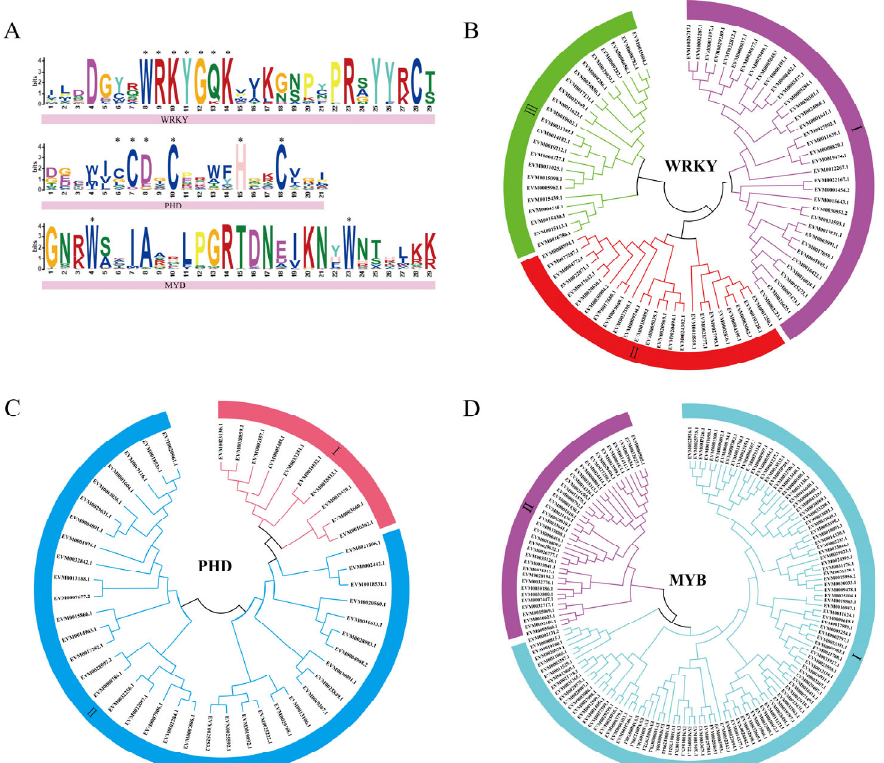
Figure 1. DNA conserved domains and evolutionary tree analysis of mungbean WRKYs , PHDs , and MYBs . ( A ) The motifs of the three gene families, in which the letter sizes of different loci in each family indicate the sequence conservation of the conserved motif (measured in bits). The size of a single letter in the letter pile indicates the size of the frequency distribution of the corresponding amino acid of the conserved motif and * in the figure indicates that the corresponding amino acid has the highest frequency distribution at this site. Phylogenetic tree of WRKYs , PHDs , and MYBs ( B – D ): each family has a different branch and each branch is shown in a different color and is marked with roman numerals such as I, II, and III.